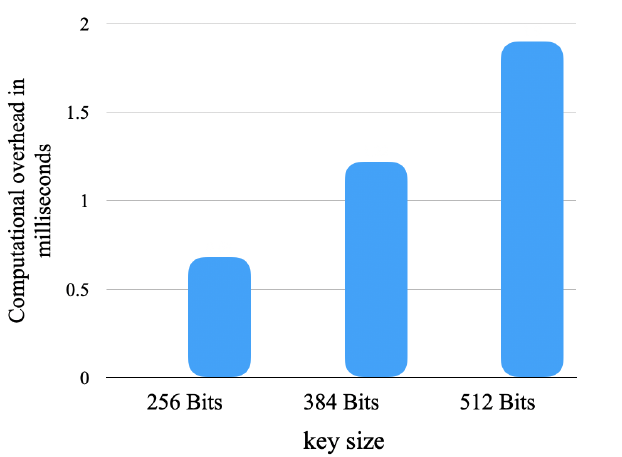
Figure 6. Encryption algorithms’ computational time in milliseconds with different key size. We vary the key size (256 bits, 384 bits, and 512 bits) and measure the time for encrypting and uploading the record to the blockchain. For each key size, we conduct the experiment 5 times and next take the